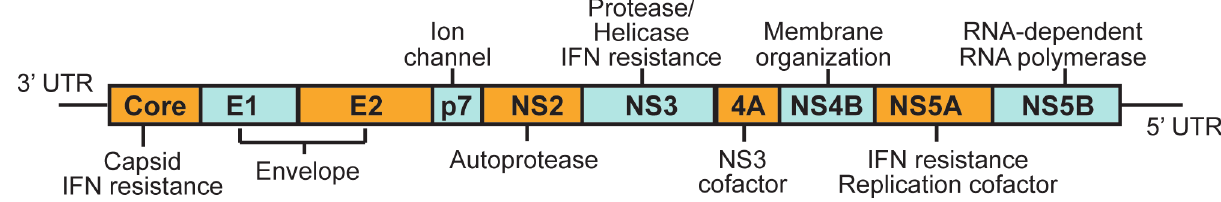
Figure 1. HCV genome. The HCV genome contains 5 9 and 3 9 untranslated regions and a single, long open reading frame that encodes 10 proteins. The mature viral proteins encoded within the open reading frame and their major functions are indicated. Reprinted from [25] under the